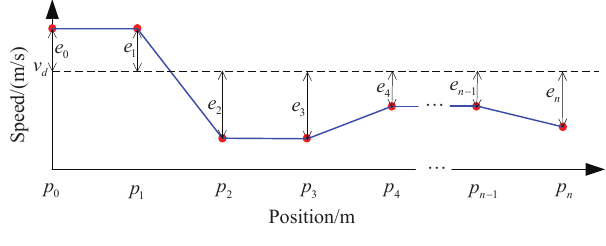
Figure 18. Speed errors at